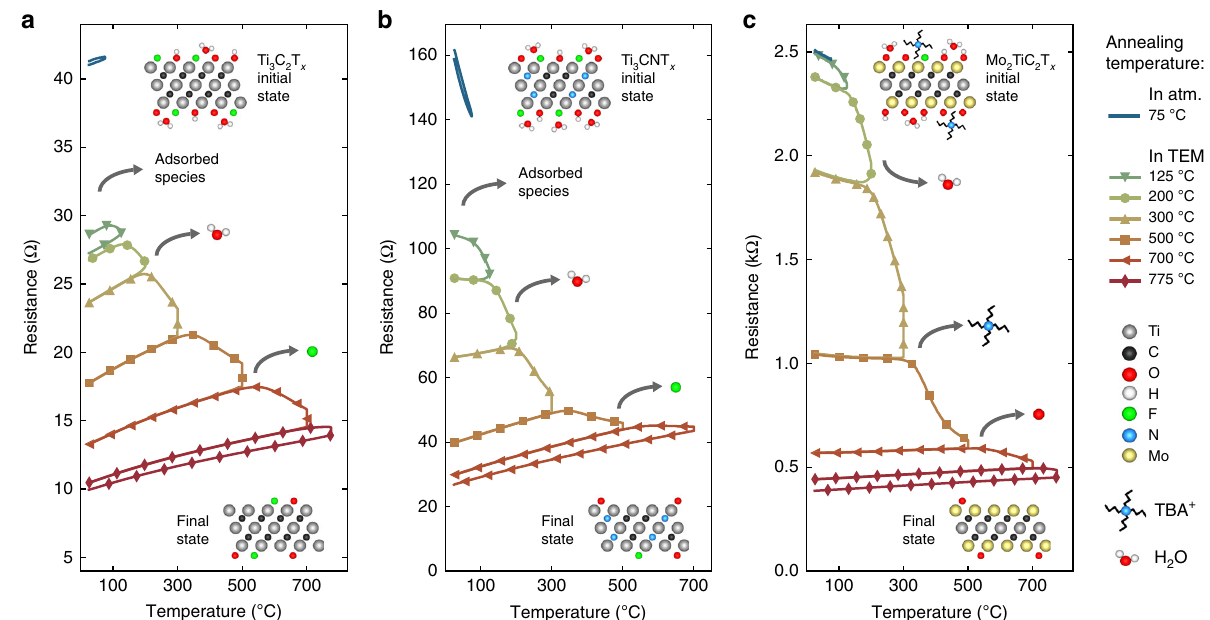
Fig. 1 Evolution of MXene electronic properties with in situ vacuum annealing. Resistance versus temperature measurements are shown for Ti 3 C 2 T x ( a ), Ti 3 CNT x ( b ), and Mo 2 TiC 2 T x ( c ). The measurements were conducted during various vacuum annealing steps performed in the TEM. Each vacuum annealing step is represented with a different color and symbol. For each annealing step, both the heating and cooling curves are shown. In all cases, the resistance decreased during annealing, hence, the cooling curve is always beneath the heating curve. The atomic structures of the various MXenes are shown as insets. The initial state schematics (top schematics) show Ti 3 C 2 T x and Ti 3 CNT x with intercalated water molecules on their surfaces, and Mo 2 TiC 2 T x is shown with water and TBA + molecules. With annealing, the MXene sample resistance is affected by the loss of adsorbed species, intercalants, and terminating species. Some of these processes are shown schematically. The resistance data in this fi gure are also shown in